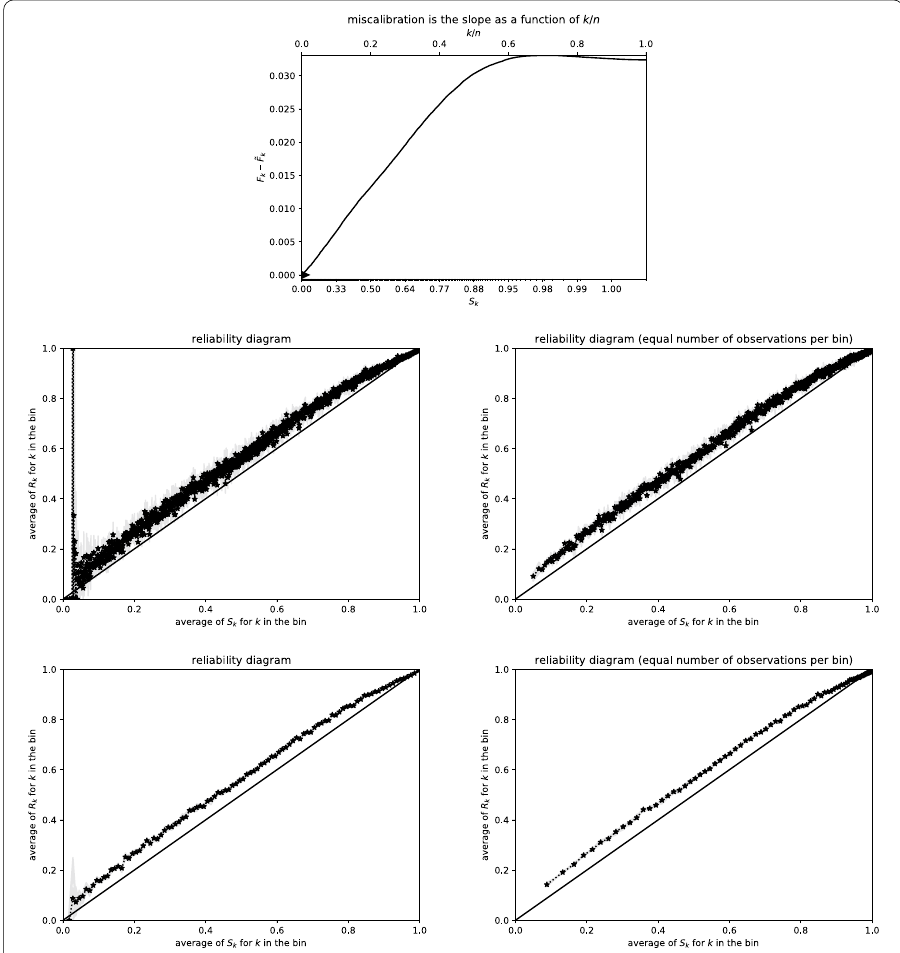
Fig. 27 Calibration of the full ImageNet-1000 training data set (the scores are the probabilities); n = 1,281,167; Kuiper’s statistic is 0.03306 /σ = 111.7 , Kolmogorov’s and Smirnov’s is 0.03306 /σ = 111.7 . The reliability diagram with 100 bins, each with roughly the same number of observations, looks best among the reliability diagrams; the reliability diagrams with 1000 bins each display unreal stochastic variations. Only the cumulative plot conveniently reveals that a third of all observations (specifically, those with probabilities of at least 0.97) are well-calibrated. The scalar summary statistics report profoundly statistically significant miscalibration, courtesy of the large number of observations (the actual effect size is more modest, as seen by the values without dividing by σ